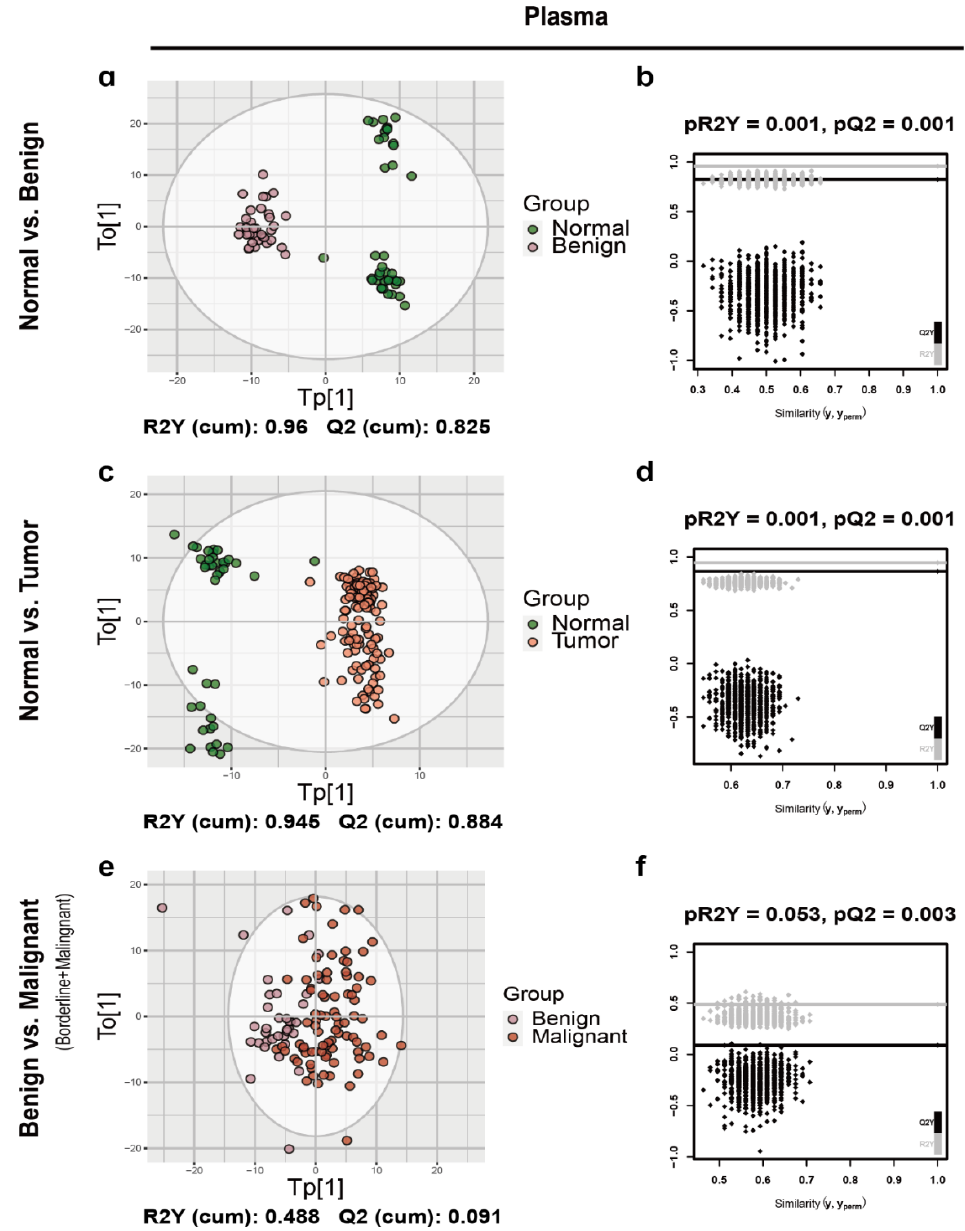
Figure 2. The OPLS-DA score plot and the permutation test results of plasma samples. The OPLS-DA score plot between ( a ) normal and benign, ( c ) normal and ovarian tumor and ( e ) benign and malignant (borderline + malignant) ovarian tumors in urine samples and the corresponding permutation test results ( b , d , f ).